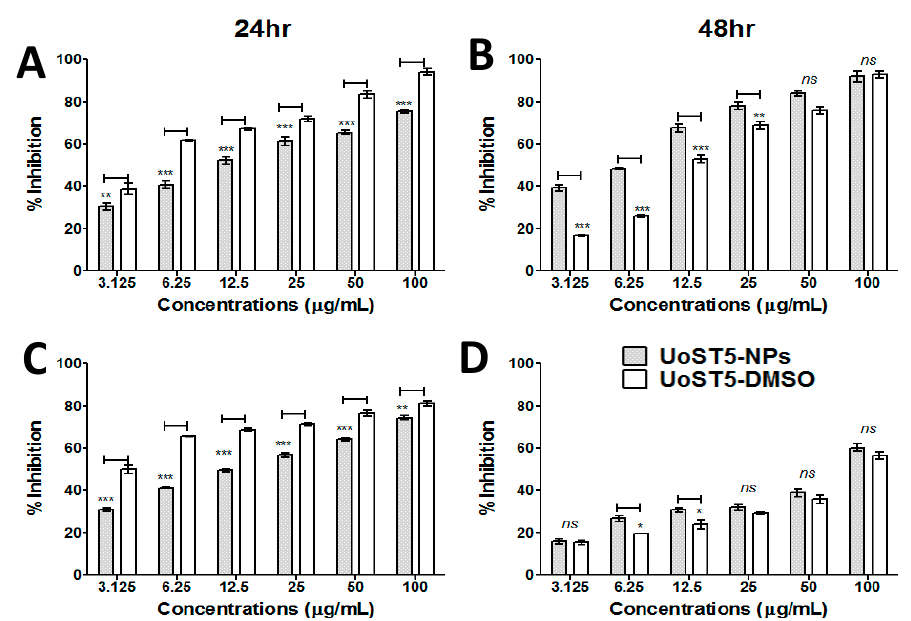
Figure 5. Anti- Candida activities of UoST5-NPs compared to free UoST5 at ( A , C ) 24 h and ( B , D ) 48 h. Figure 5. Anti -Candida activities of UoST5-NPs compared to free UoST5 at ( A ) and ( C ) 24 h and ( B ) ( A , B ) represent the e ff ects of the drugs on C. albicans , while ( C , D ) represent the e ff ects of the drugs on C. and ( D ) 48 h. ( A ) and ( B ) represent the effects of the drugs on C. albicans , while ( C ) and ( D ) represent auris . Candida growth inhibition was measured at di ff erent concentrations (3.125, 6.25, 12.5, 25, 50 and the effects of the drugs on C. auris . Candida growth inhibition was measured at different 100 µ g / mL). Candida at 10 4 CFU / mL was grown in 96 well microplate containing YPD broth. The plates concentrations (3.125, 6.25, 12.5, 25, 50 and 100 µg/mL). Candida at 10 4 CFU/mL was grown in 96 well were incubated at 37 ◦ C for 24 h prior to measurement at 600 nm using plate reader. Cultures without microplate containing YPD broth. The plates were incubated at 37 °C for 24 h prior to measurement compounds were employed as negative control in order to measure percent inhibition. The data was at 600 nm using plate reader. Cultures without compounds were employed as negative control in analyzed using two-way ANOVA and statistical significance was calculated with Bonferroni’s multiple order to measure percent inhibition. The data was analyzed using two-way ANOVA and statistical comparisons test and significance level indicated by asterisks (* P < 0.05; ** P < 0.01: *** P < 0.001). significance was calculated with Bonferroni’s multiple comparisons test and significance level The data display the mean ± standard error (SEM) of three indicated by asterisks (* P < 0.05; ** P < 0.01: *** P < 0.001). The data display the mean ± standard error (SEM) of three replicates.